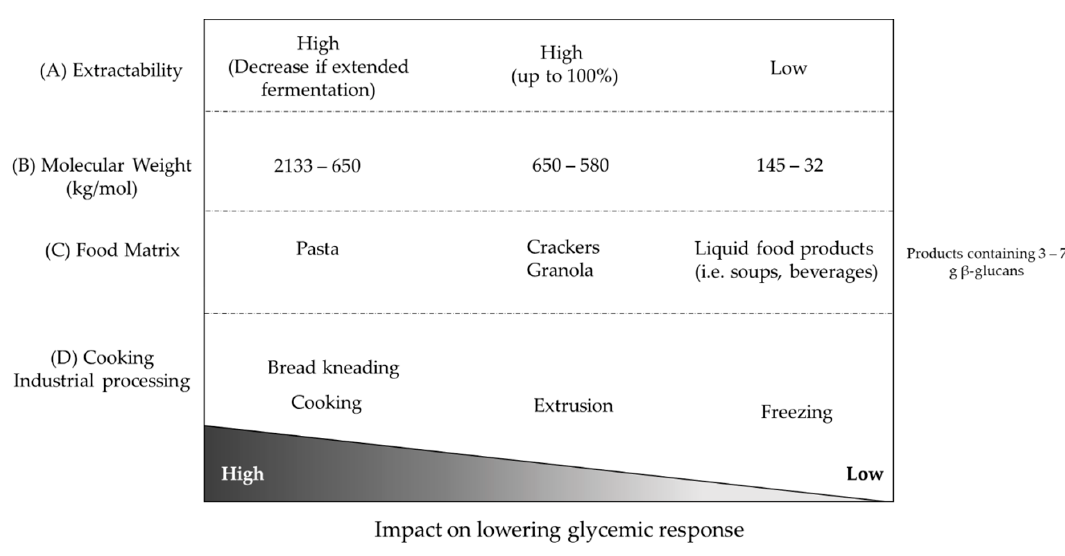
Figure 2. A schematic overview of the typical processing-induced changes to cereal β -glucan structure reported in this review. The ability to lower glycaemic response is expressed as a gradient from high to low. ( A ) A high β -glucan extractability has more e ff ect on decreasing glucose response as compared to a low extractability. ( B ) Similarly, β -glucans with increasing molecular weight have better ability to reduce glucose response. ( C ) Pasta with 3-7 g of β -glucans shows the highest e ffi cacy for decreasing glucose response, while crackers and granola have an intermediate e ff ect. Liquid